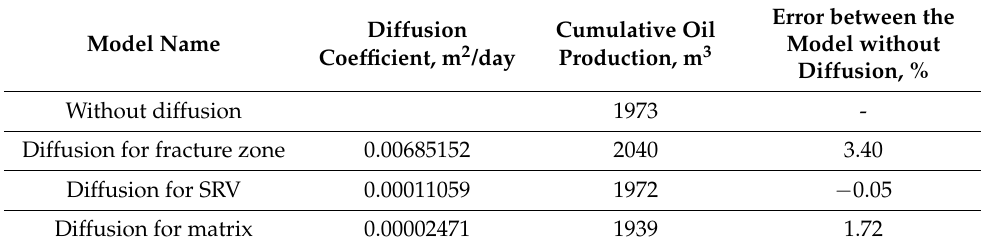
Table 7. Results of model calculations with different diffusion